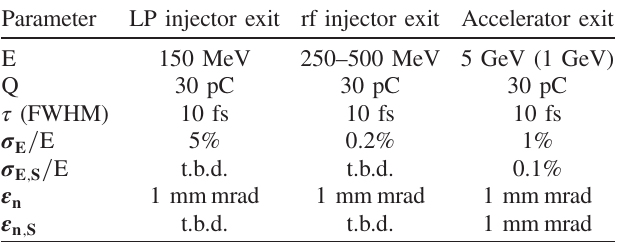
TABLE I. Main requirements for the electron beam at the exit of the injector, which can be either a laser-plasma (LP) injector or a radio-frequency (rf) injector, and at the accelerator exit, which means at the user application. E, Q, τ ð FWHM Þ , σ E = E, σ E;S = E, ε n , and ε n;S stand, respectively, for beam energy, charge, length (full width at half maximum), rms energy spread, slice energy spread, normalized phase emittance, and slice normalized phase